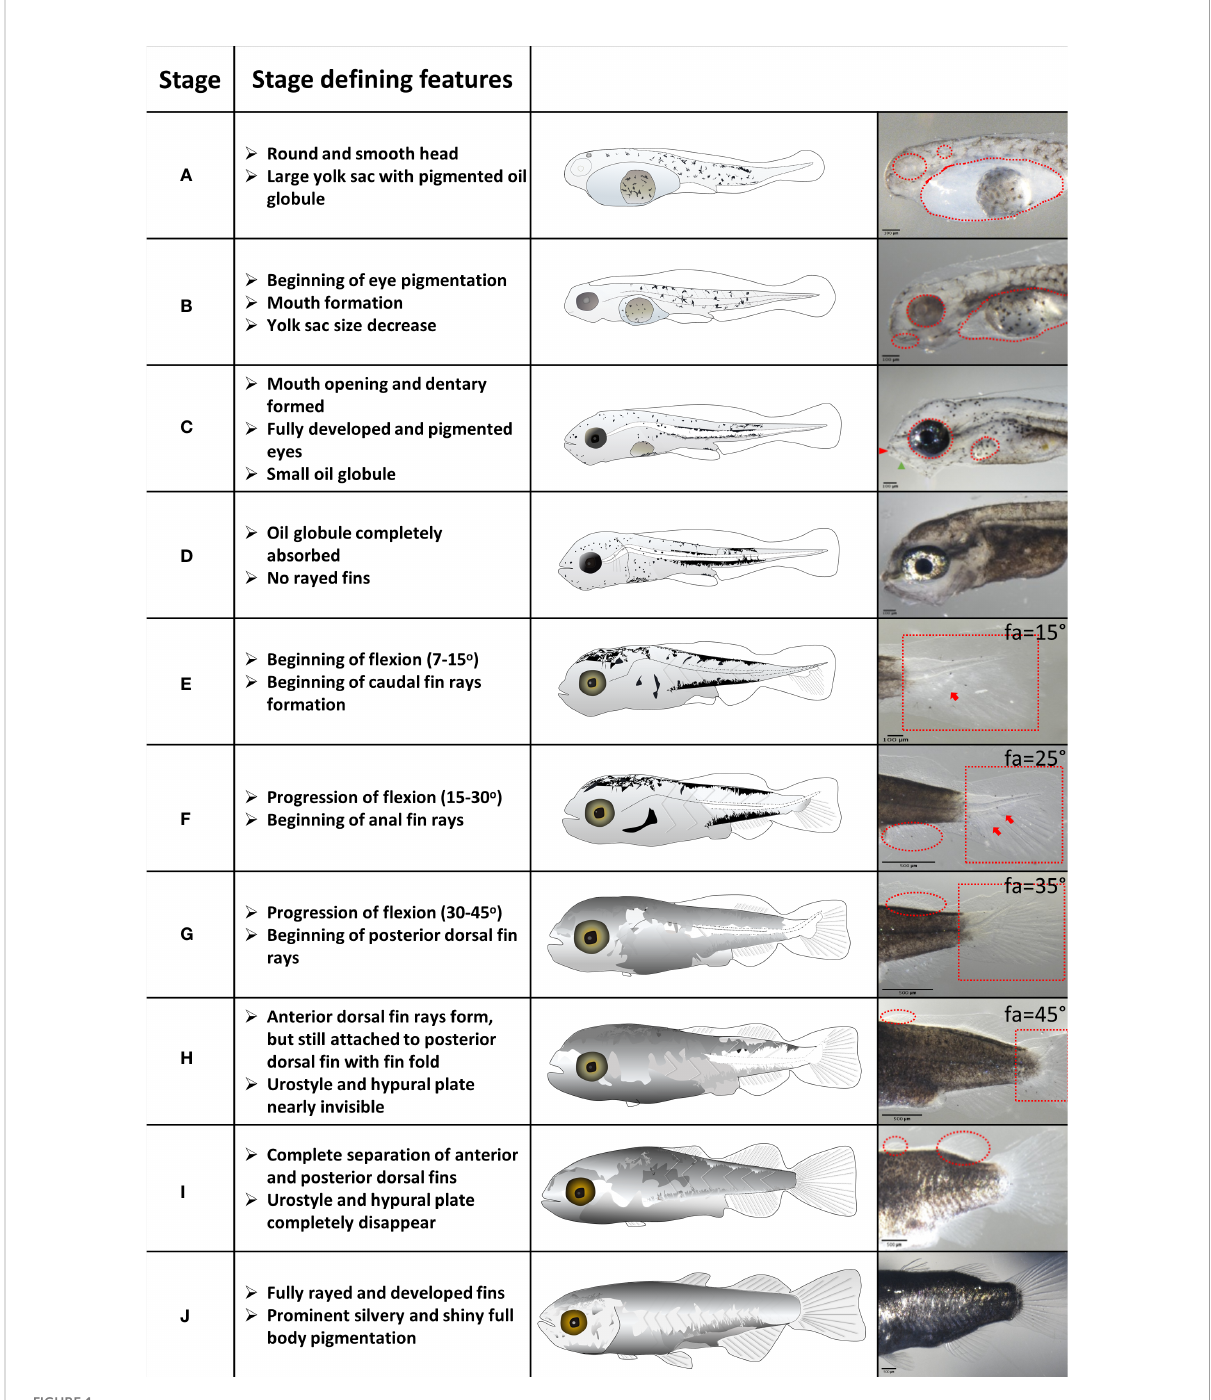
FIGURE 1 Stages of grey mullet larval development and metamorphosis. Stage de fi ning features are described for each developmental stage. Important features are marked in red on the images in the right column. Fa – Flexion angle. Scale bar: Stages A to E – 100 µm; stages F to J – 500